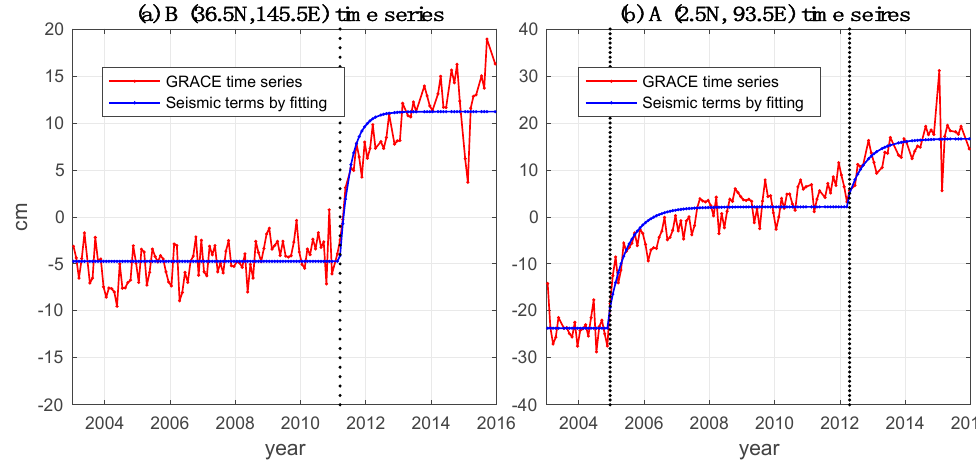
Figure 2. The time series fitting examples at two selected points, with the co- and post-seismic terms taken into account. ( a ) The time series fitting includes the effect of only one earthquake (i.e., the March 2011 Tohoku-Oki earthquake) and ( b ) the fitting includes the effect of two earthquakes (i.e., the December 2004 and April 2012 Sumatra earthquakes). The red curve represents the original time series observed by GRACE. The blue curves represent the fitted co- and post-seismic terms. The vertical dashed lines denote the occurrence months of the earthquakes.